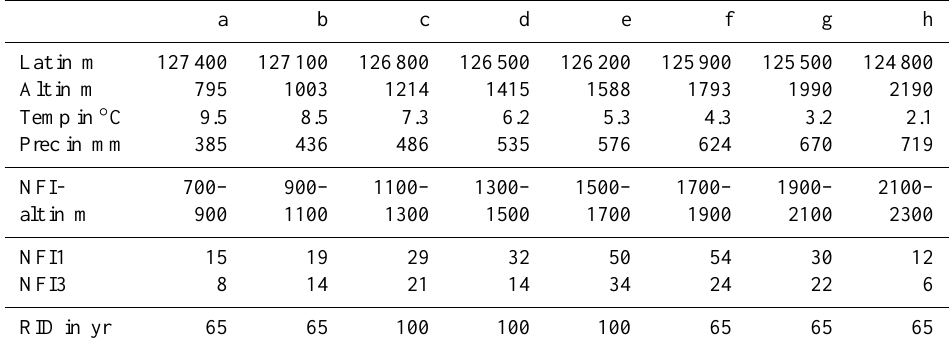
Table 2. Specific characteristics for stands a to h. Lat: latitude in Swiss coordinates (CH1903/lv03 projection; longitude is 638300m for all stands); Alt: altitude above sea level; Temp: mean annual temperature; Prec: sum of precipitation of main growing period (April–September); NFI-alt: altitudinal range set for NFI plots associated with the modeled stands; NFI1, NFI3: numbers of plots per altitudinal range; RID: return intervals for generic, patch-destroying